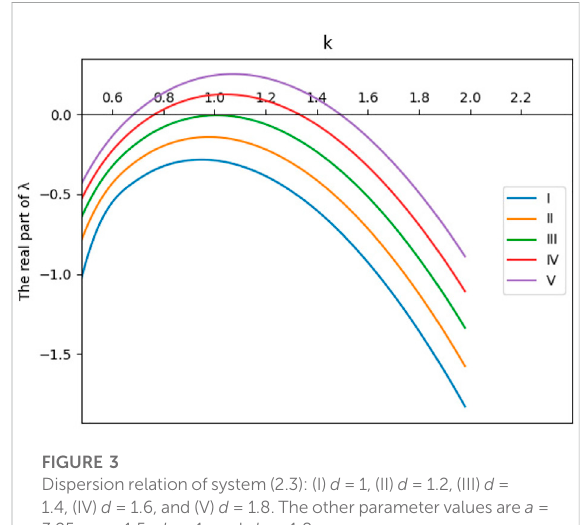
FIGURE 3 Dispersionrelationofsystem(2.3):(I) d =1,(II) d =1.2,(III) d = 1.4, (IV) d = 1.6, and (V) d = 1.8. The other parametervaluesare a = 3.25, m = 1.5, d 1 = 1, and d 2 = 1.8.